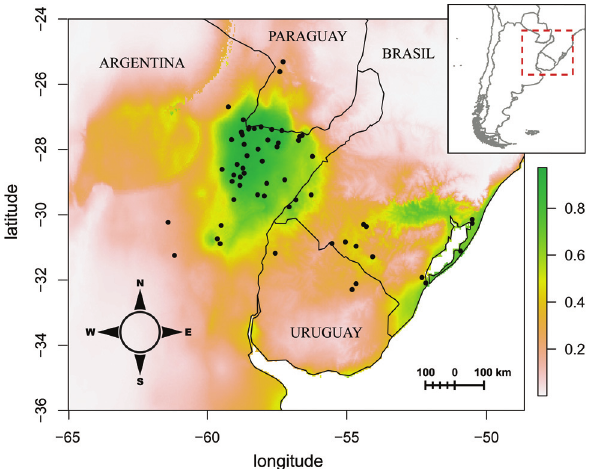
Figure 5 - Species distribution model prediction of the probability of oc- currence and habitat suitability of Paspalum modestum in the studied area and surrounding region. Realized (black dots) and potential habitat suit- ability (inferred from AUC values) of the species. Green and yellow areas represent the zone where ecological conditions meet the species require-